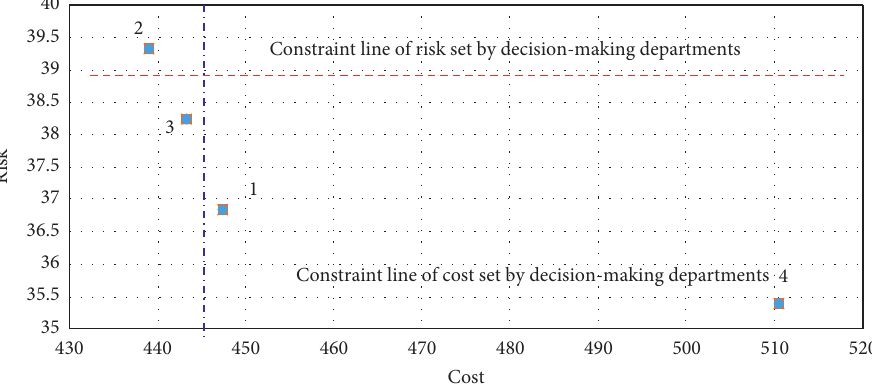
Figure 14: Pareto optimal path based on transportation cost and